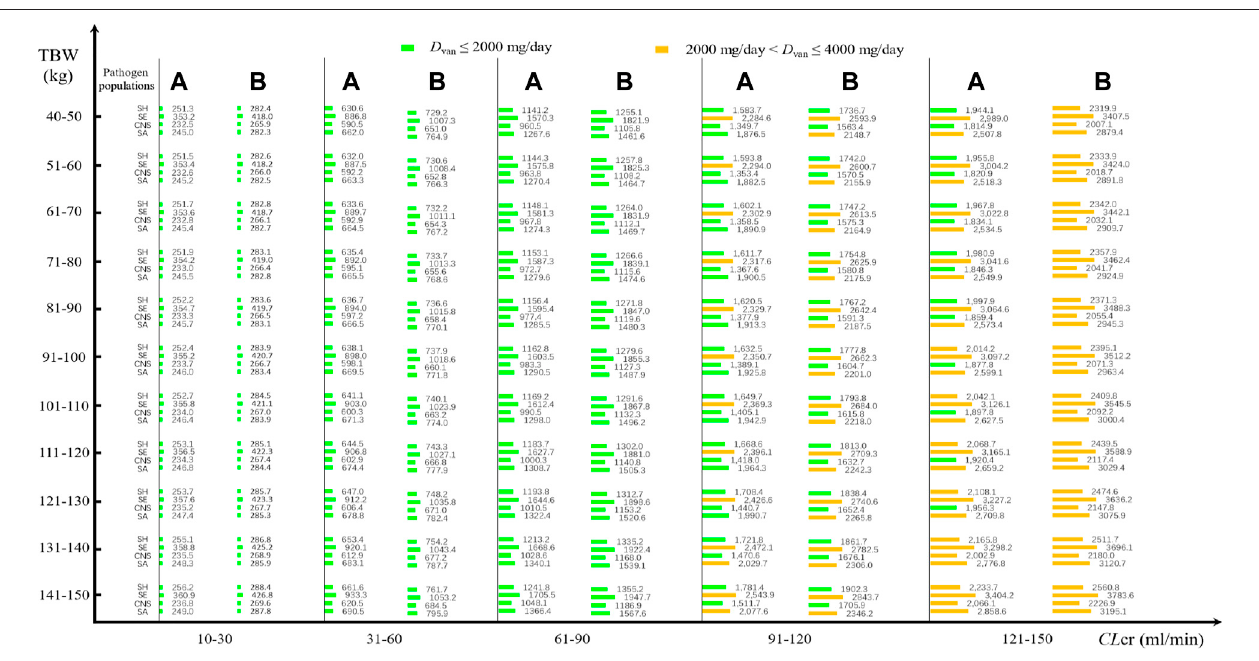
Frontiers in Pharmacology |